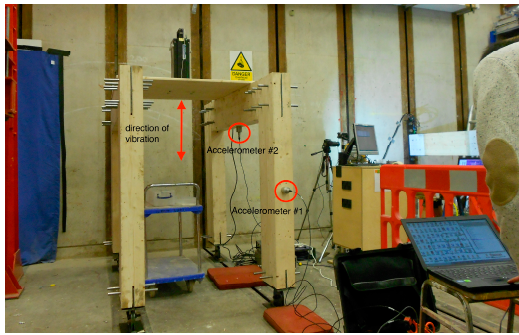
Table 1. Summary of the experimental tests performed in laboratory.